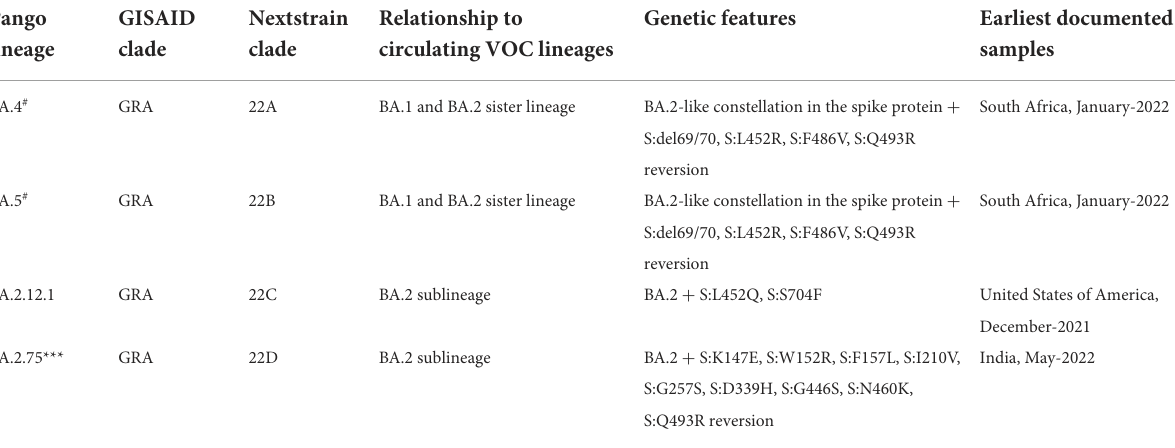
TABLE 1A List of variants designated as variants under monitoring according to the WHO as of September 15,